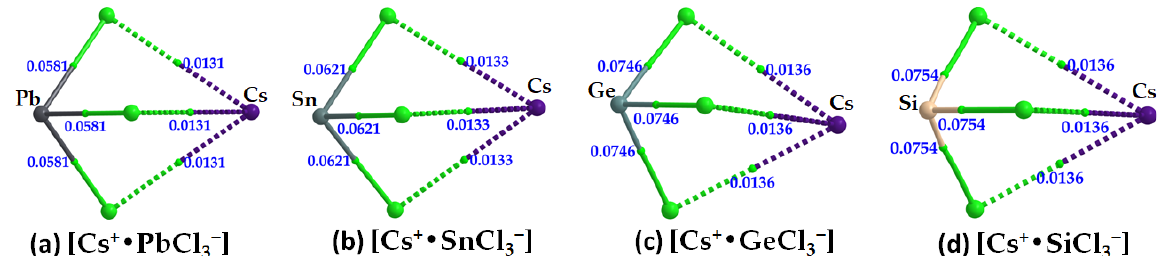
Figure 10. ( a – d ) QTAIM-based molecular graphs of cesium tetrel chloride perovskite ion-pairs, [Cs + •TtCl 3 − ] (Tt = Pb, Sn, Ge and Si), obtained with [ ω B97XD/def2-TZVPPD]. Values represent the charge density ( ρ b /au) at the Tt–Cl and Cs···Cl bond critical points. Atoms, bond paths, and bond critical points are shown as large spheres, solid/dotted lines in atom color, and tiny spheres in green, respectively. Table 3. Selected QTAIM-based topological charge density properties at Tt–Cl and Cs···Cl bcps of